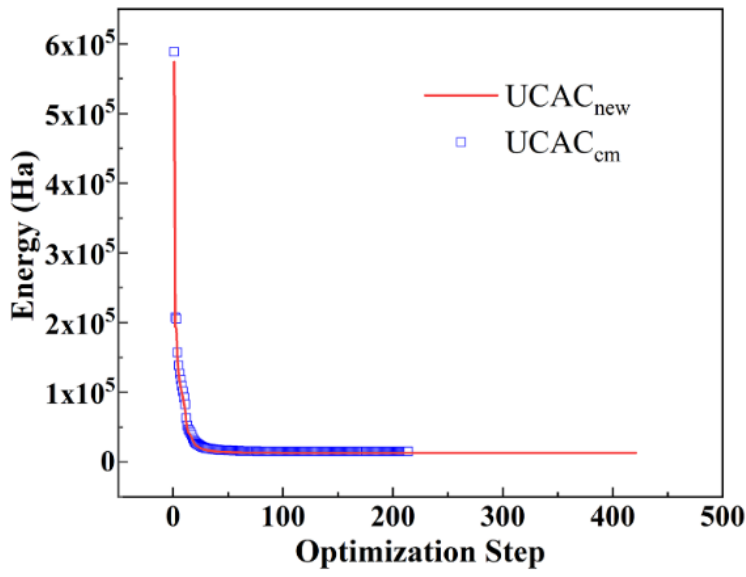
Figure 11. Energy change during optimization of UCAC new and UCAC cm models. Table 4. Simulated adsorption amounts of UCAC new and UCAC cm